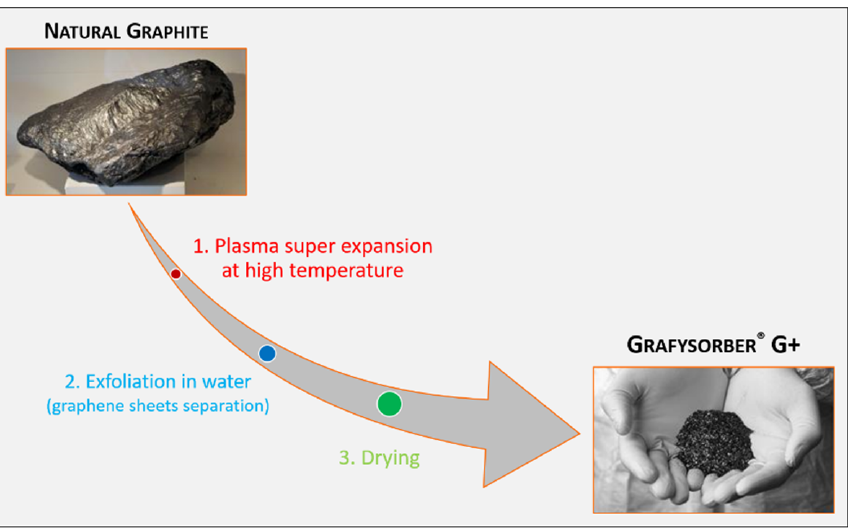
Figure 1. The production process of Grafysorber ® G+.